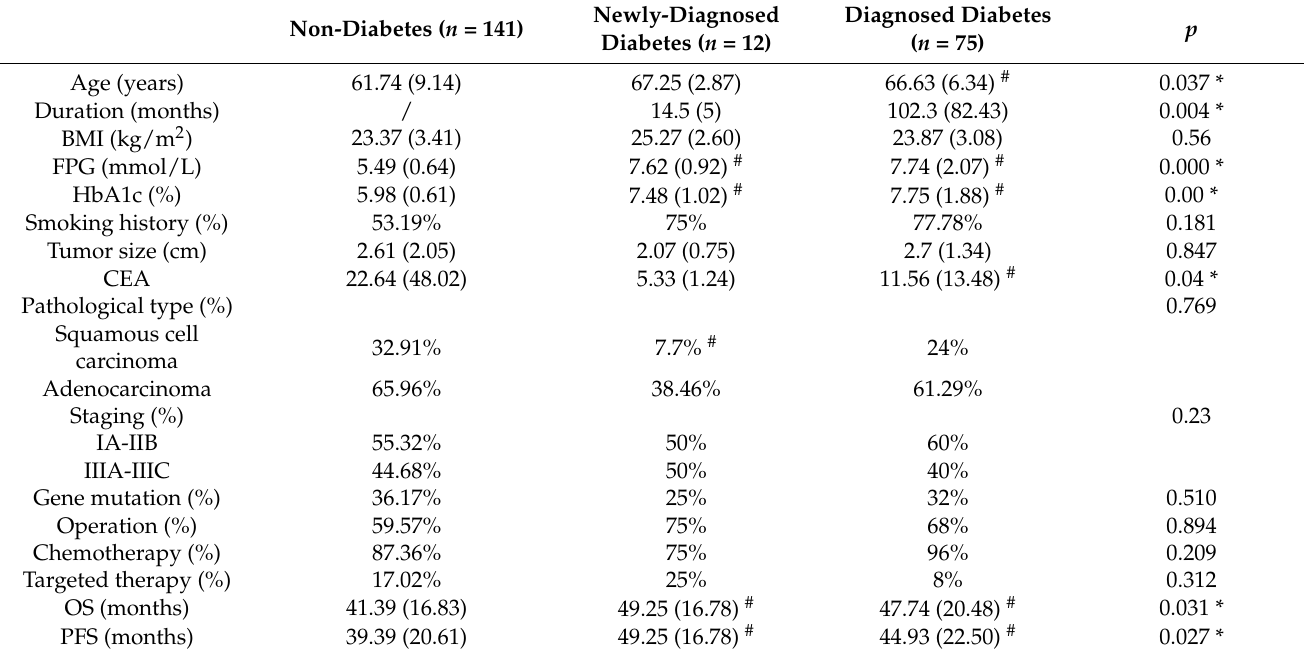
Table 2. Comparison of tumor related characteristics in different status groups of